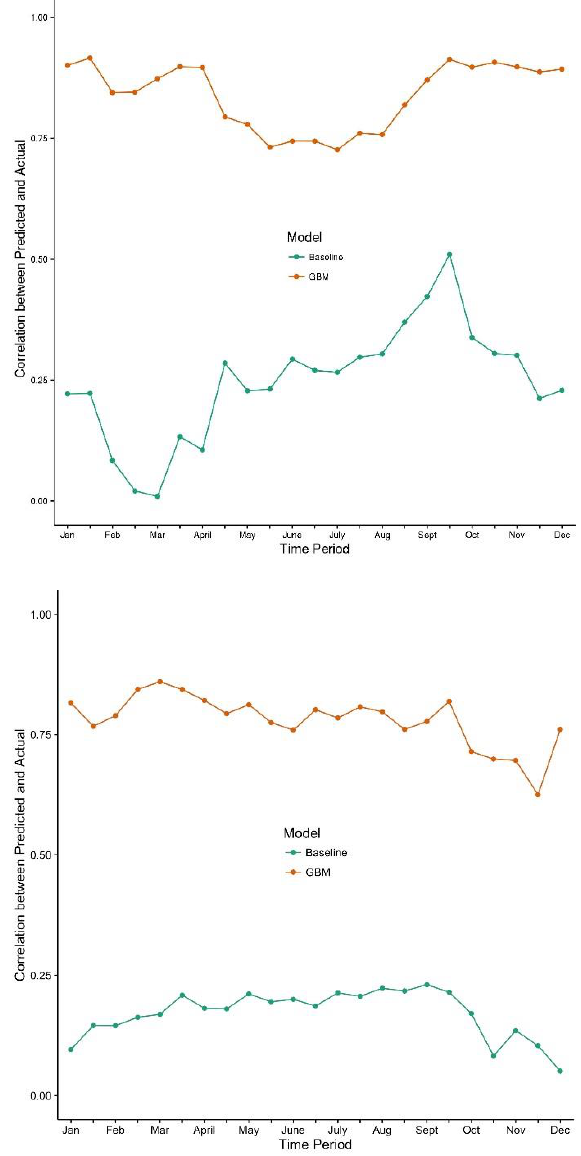
Figure 1: Correlation between predicted and actual EVI in (A) Bangladesh and (B) Sri Lanka across land use categories